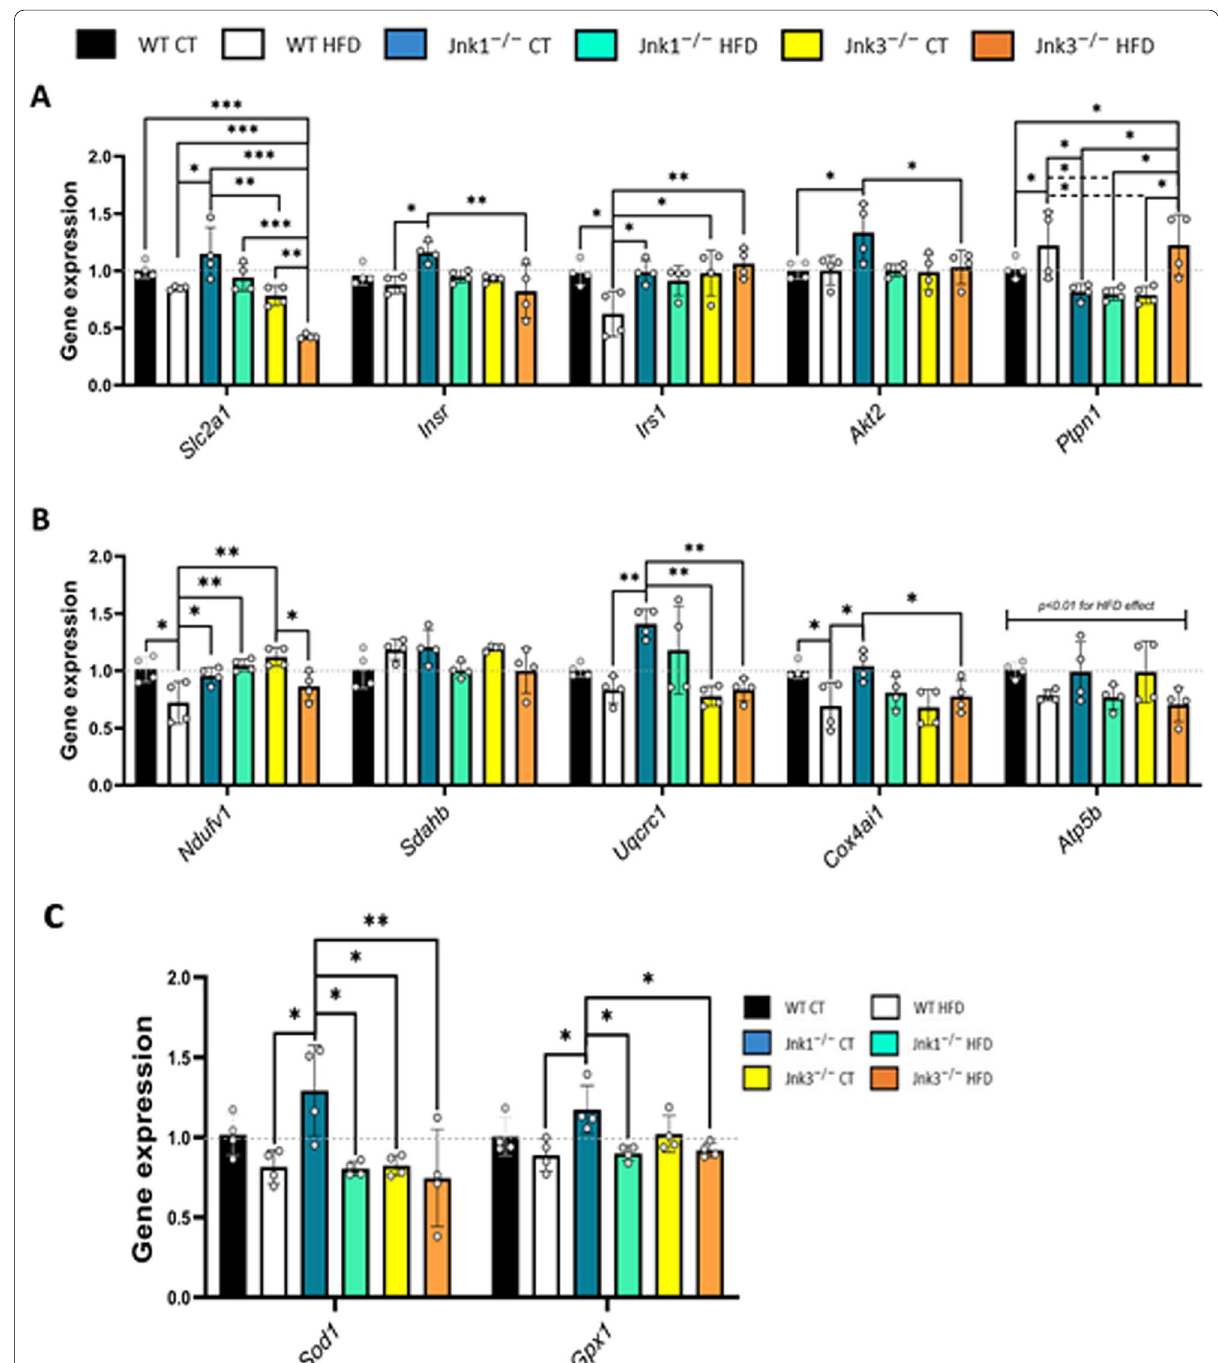
Fig. 3 Loss of function of JNK1 and JNK3 cause changes in the transcriptomic profile of genes linked to: A glucose uptake and insulin signaling, B mitochondrial electron transport chain and C antioxidant enzymes (n 4 per experimental group). Results were represented as bar graphs. = Differences between groups were analyzed using ANOVA and Tukey’s. Significance was represented as follows: *p < 0.05, **p < 0.01 and ***p <